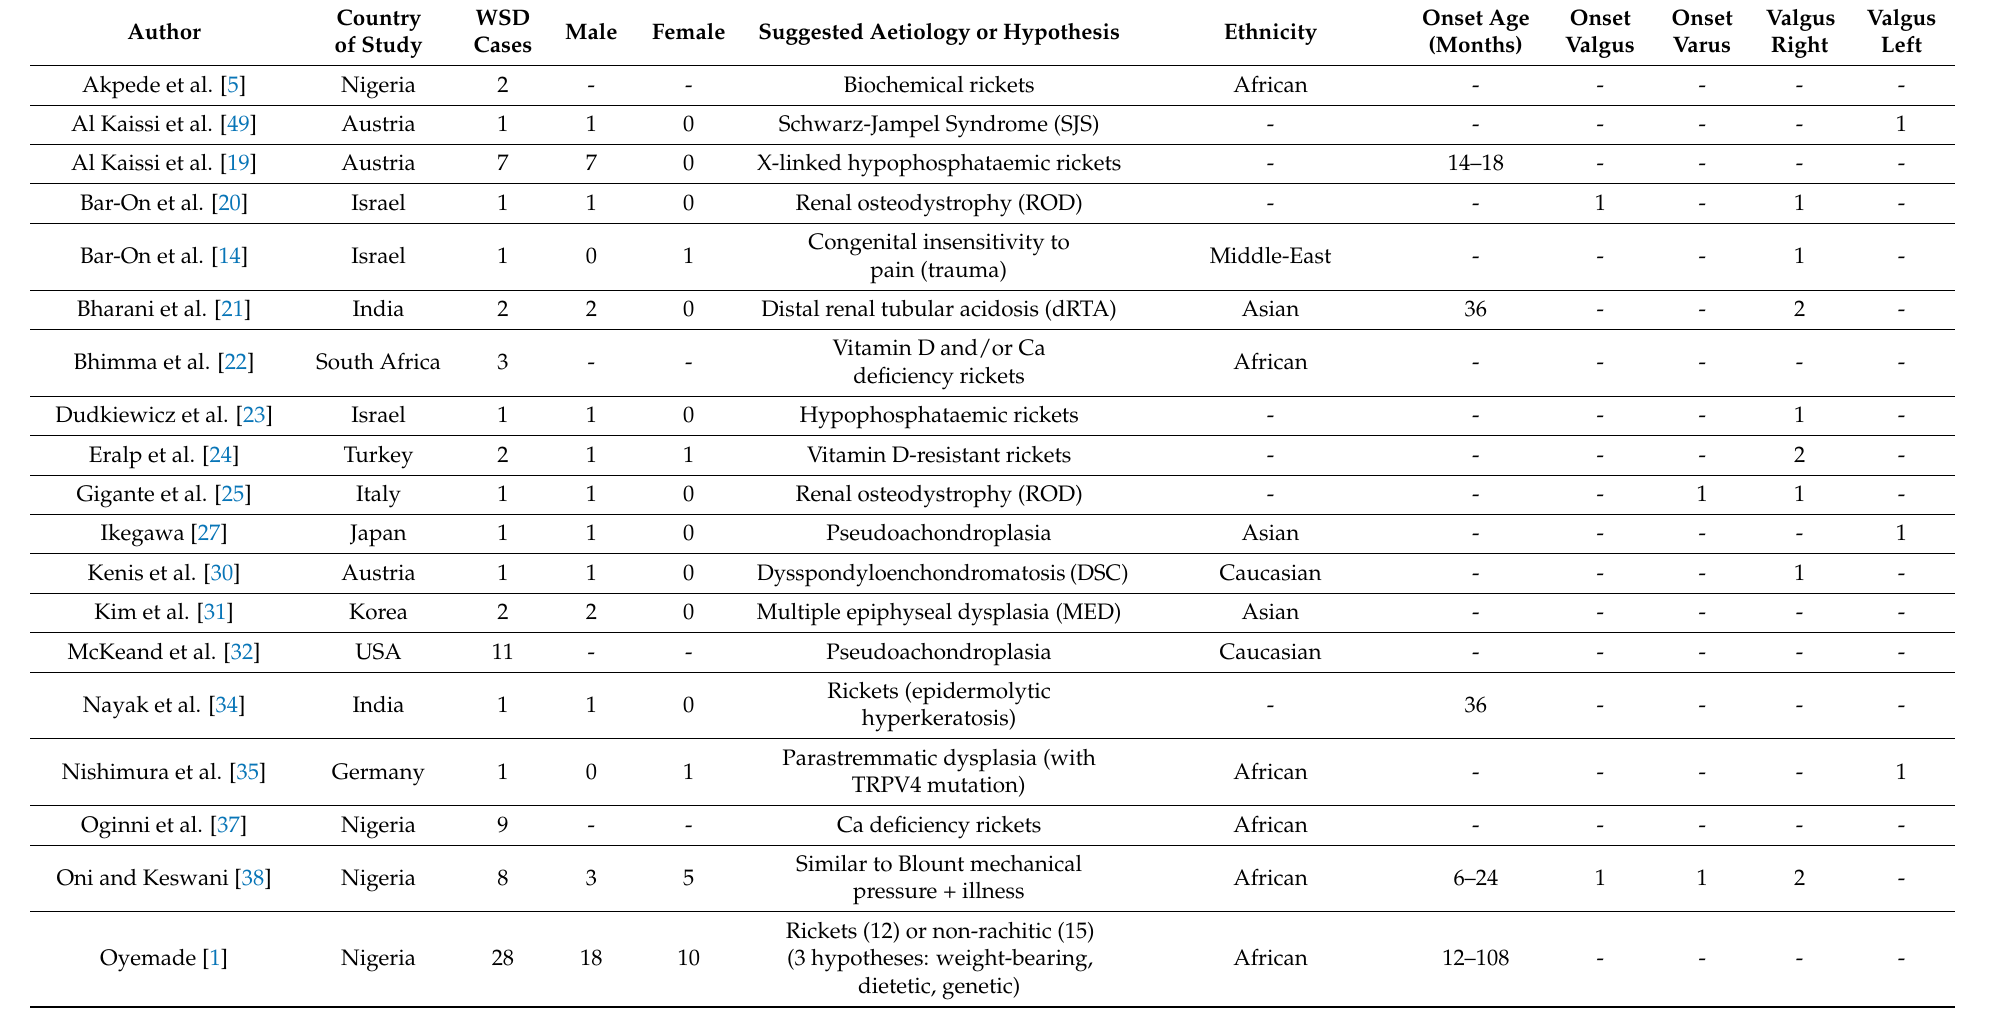
Table 2. Quantitative overview of the demographic data from the studies describing the aetiology windswept deformity